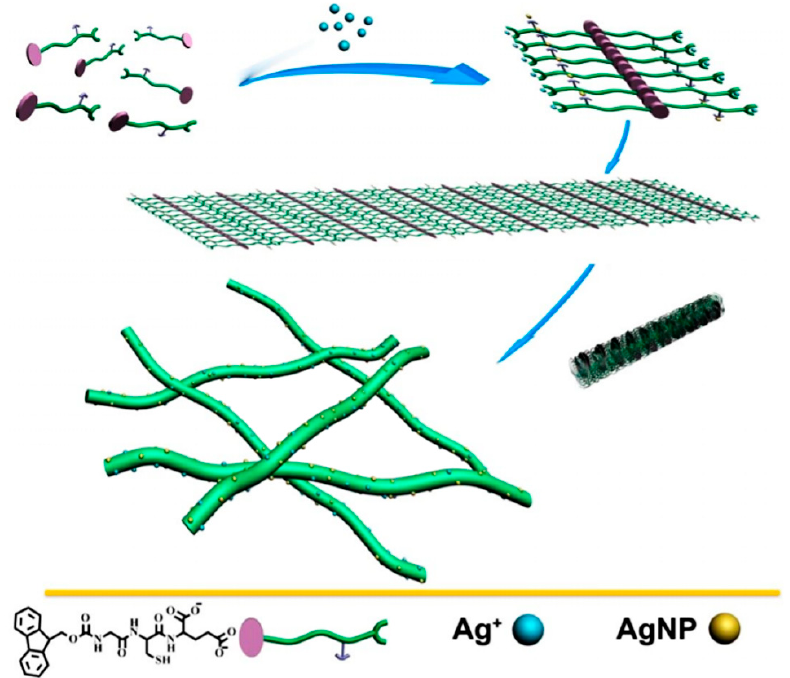
Figure 2. The templating effect of a tripeptide gelator bearing carboxylates and a thiol moiety for Ag + coordination results in the formation of silver nanoparticles (AgNP) onto the gelling nanofibers that arise from the peptide stacks. Reprinted with permission from [46]. Copyright © 2021, Ameri- can Chemical Society.